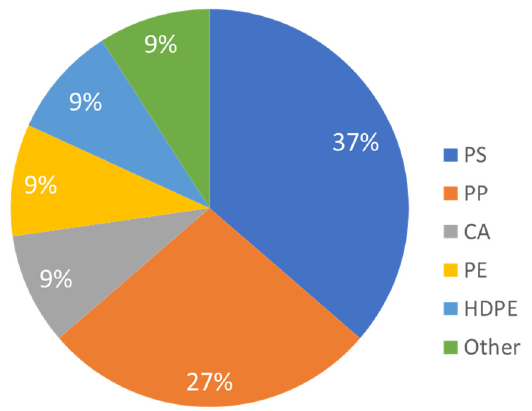
Figure 6. Occurrence of the top-three most abundant polymers in the four articles examining this parameter. PS = polystyrene; PP = polypropylene; CA = cellulose acetate; PE = polyethylene; HDPE = high-density polyethylene.